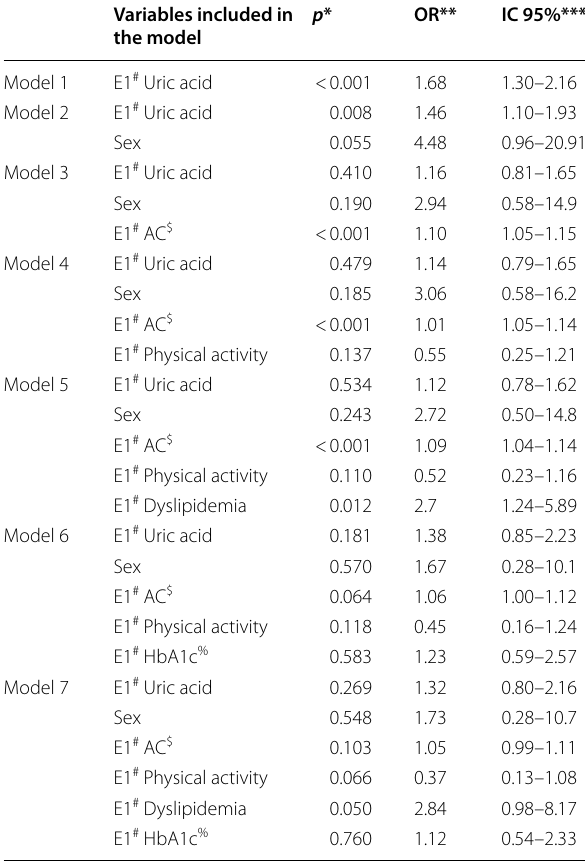
Table 3 Results of the adjustment of multivariate models for steatosis progression considering variables of the first evaluation of